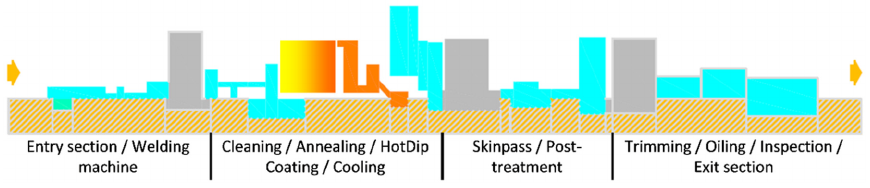
Figure 1. Layout of the considered Hot Dip Galvanizing (HDG) line.